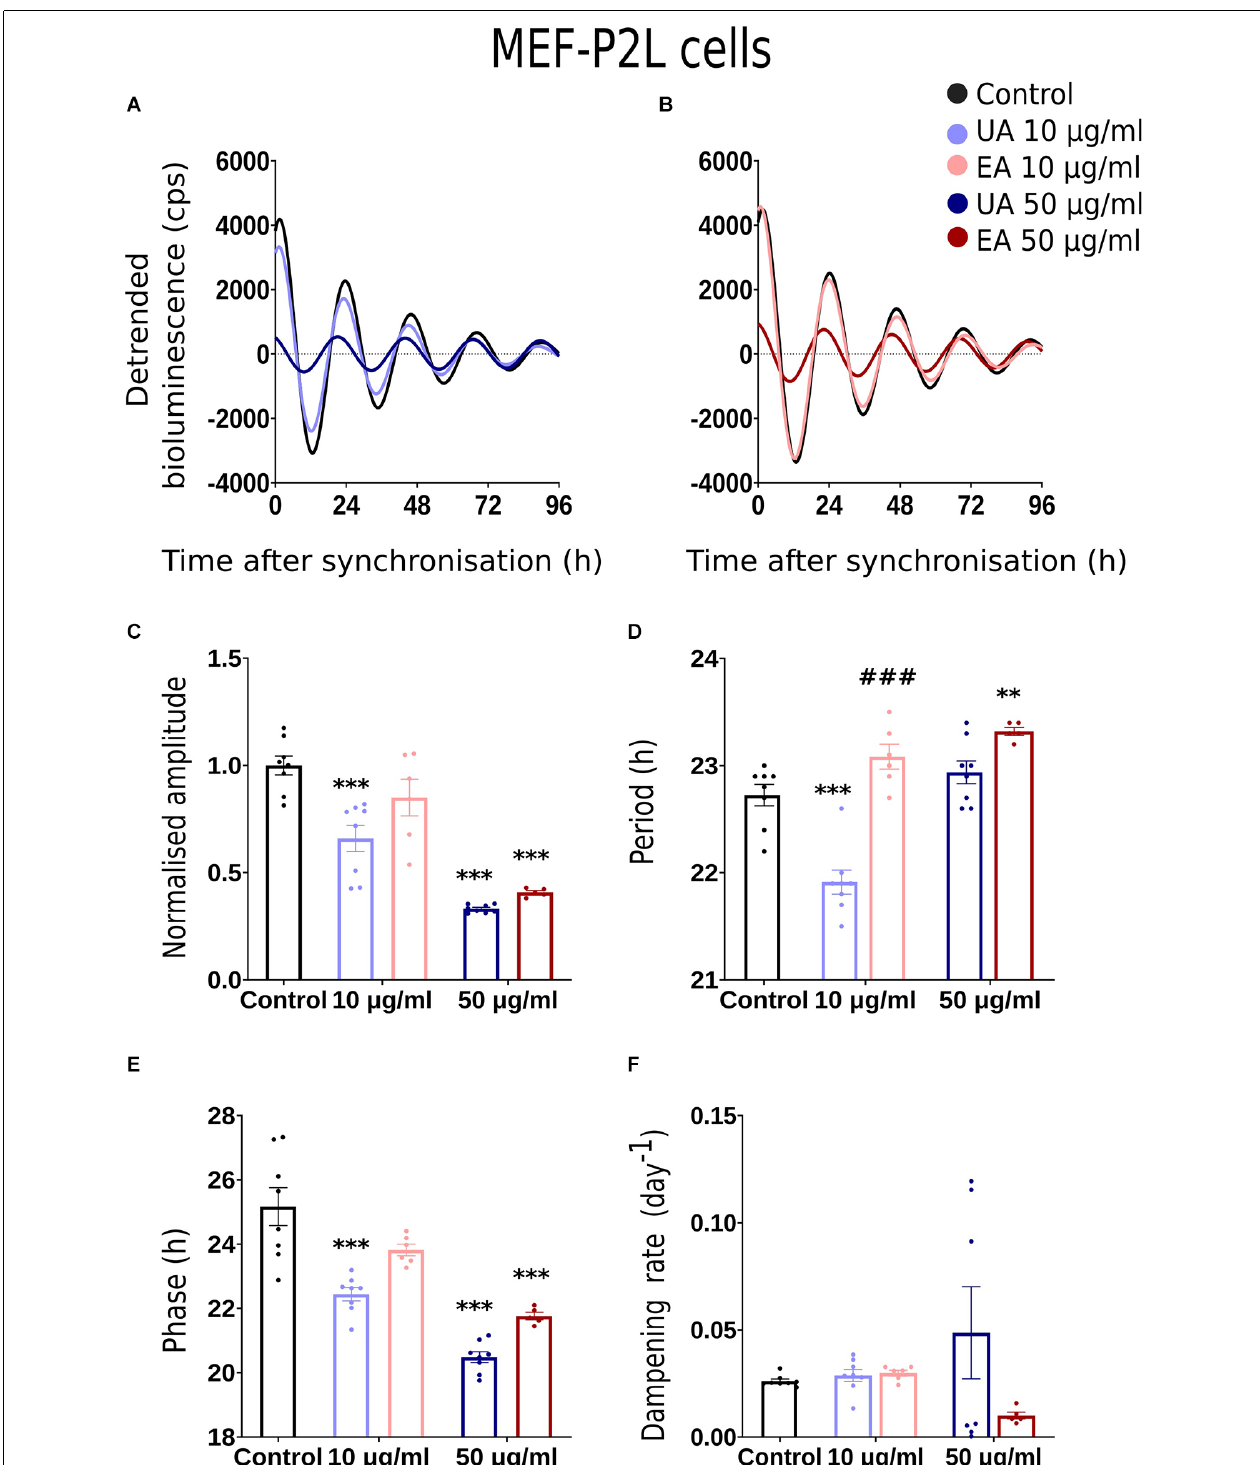
FIGURE 4 | Effects of lichenized secondary metabolites on circadian luminescence rhythms of MEF-P2L cells. Representative curve fits of Per2:luc luminescence rhythms in MEF cells after treatment with different doses of usnic acid ( A , UA/Blue) or evernic acid ( B , EA/Red). Amplitude (C) , Period (D) , Phase (E) , and Dampening effects (F) on bioluminescence rhythms in MEF cells after treatment with EA (10 or 50 µ g/ml; red) or UA (10 or 50 µ g/ml; blue) vs. solvent control (PBS/ DMSO; black). Single measures are shown; error bars indicate means ± SEM ( ∗∗ p < 0.01, ∗∗∗ p < 0.001; 2-way ANOVA with Tukey’s post-test). ### p < 0.001 between UA 10 vs. EA 10 or UA 50 vs. EA